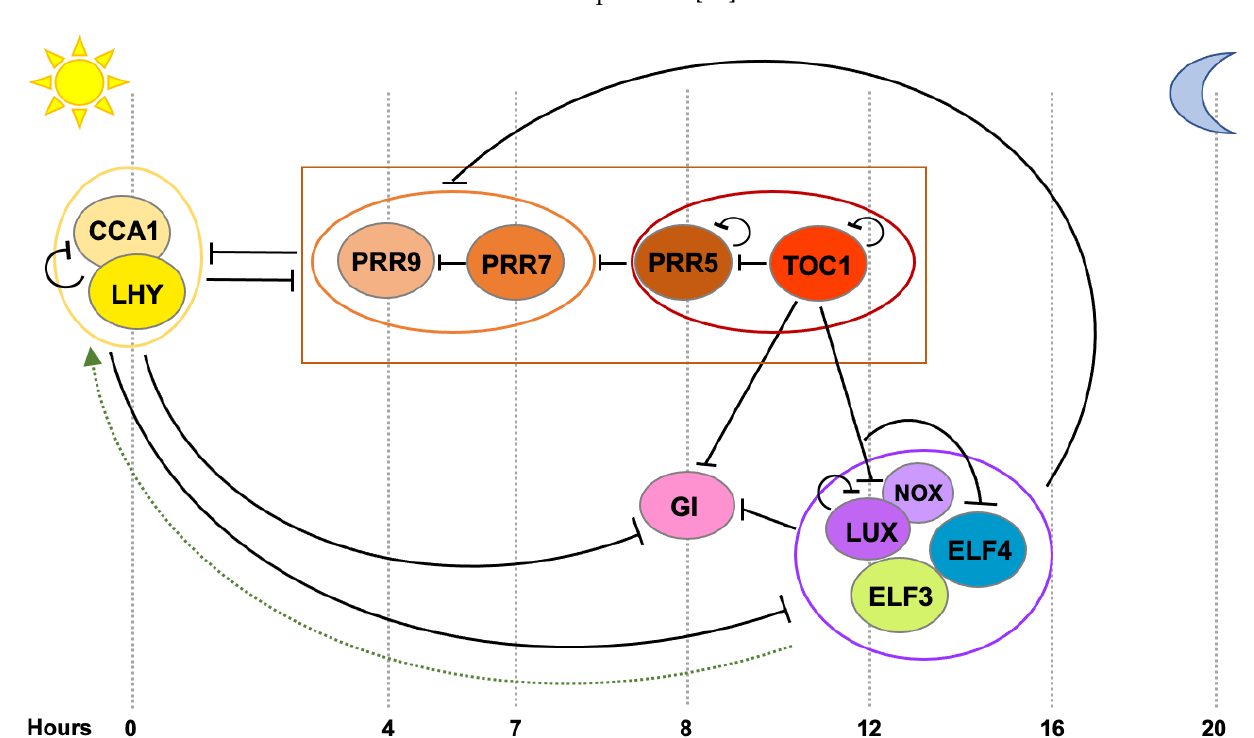
Figure 1. Transcriptional feedback loops at the core of the circadian oscillator in Arabidopsis thaliana . Clock components are sequentially expressed across the day as depicted from left to right. Black bars indicate repression of transcription and the broken green arrow, activation of transcription not proven to be direct. At dawn, CCA1 and LHY repress the expression of the PRRs , GI and the members of the Evening Complex (EC) LUX , ELF3 and ELF4 . PRR9, PRR7, PRR5 and TOC1 are sequentially expressed and repress the expression of CCA1 and LHY , as well as each other’s. In the evening, TOC1 represses CCA1 , LHY and the PRRs , as well as GI , LUX and ELF4 . Later, the EC maintains repression on GI , PRR9 and PRR7 and likely indirectly activates CCA1 and LHY .